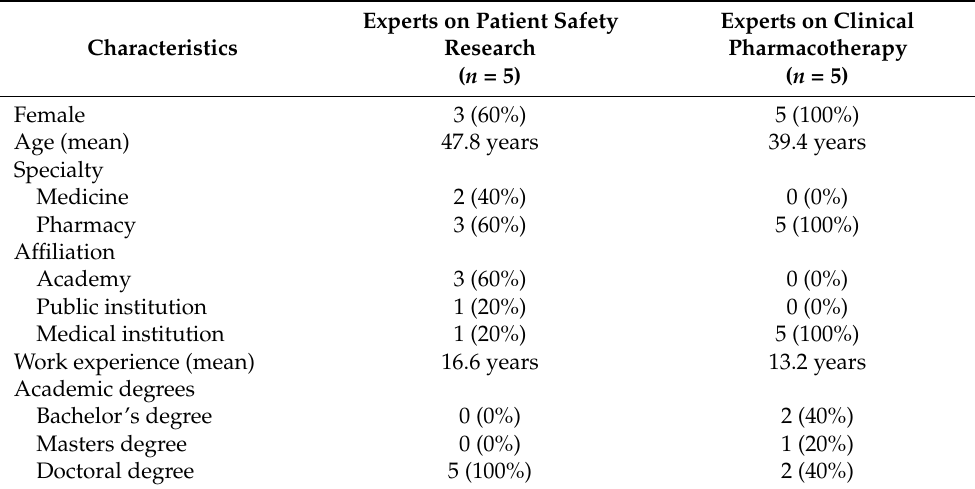
Table 1. Characteristics of experts who compared each pair of criteria and alternatives regarding prevention strategies on medication